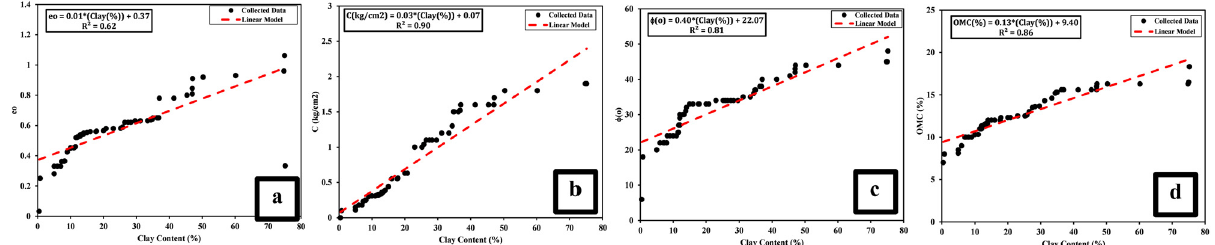
Figure 9: The variation in various soil characteristics vs clay content for Kirkuk city: ( a ) e o vs clay content ( % ) , ( b ) c ( kg/cm 2 ) vs clay content ( % ) , ( c ) ϕ vs clay content ( % ) , and ( d ) OMC ( % ) vs clay content ( % )